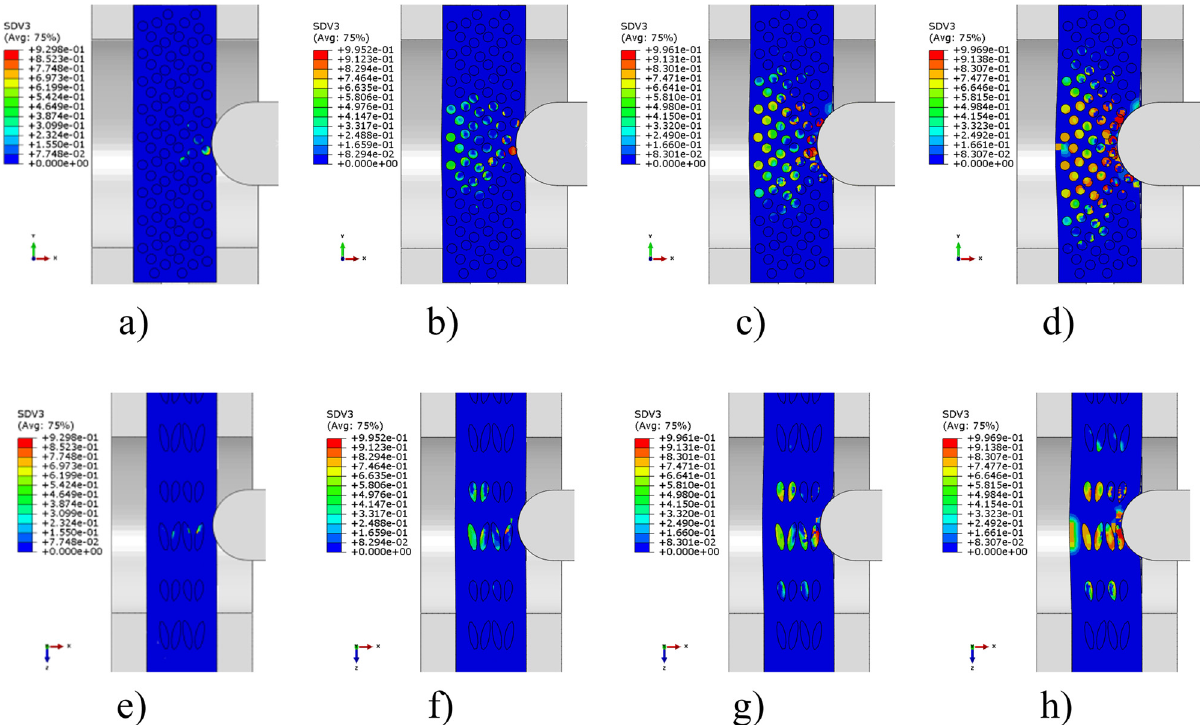
Figure 17: Transverse tensile damage of fi ber bundles and matrix: ( a – d ) fi ber bundles and ( e – h ) matrix.